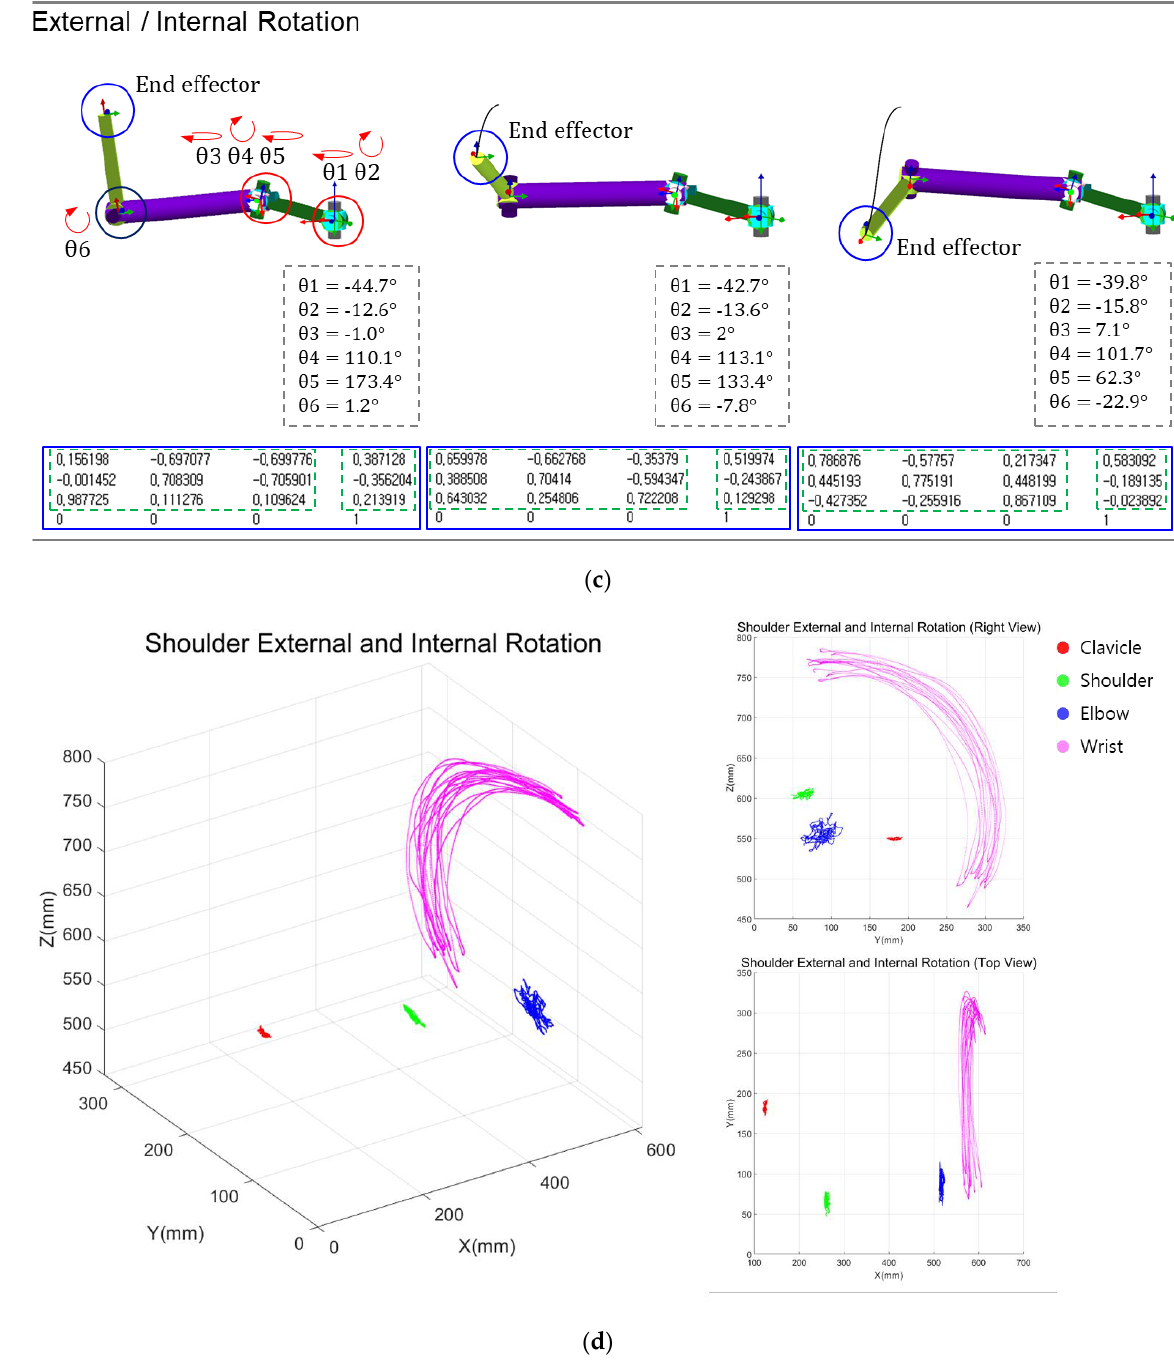
Figure 9. Joint rotation angle with ROM and simulation. ( a ) Realized rotation degree variation in external and internal rotation. ( b ) Average ROM for males and females. ( c ) Simulation results of external and internal rotation. ( c , d ) Simulation results of abduction and adduction. ( d ) Joint-centered trajectory graph in a 6-axis arm structure.